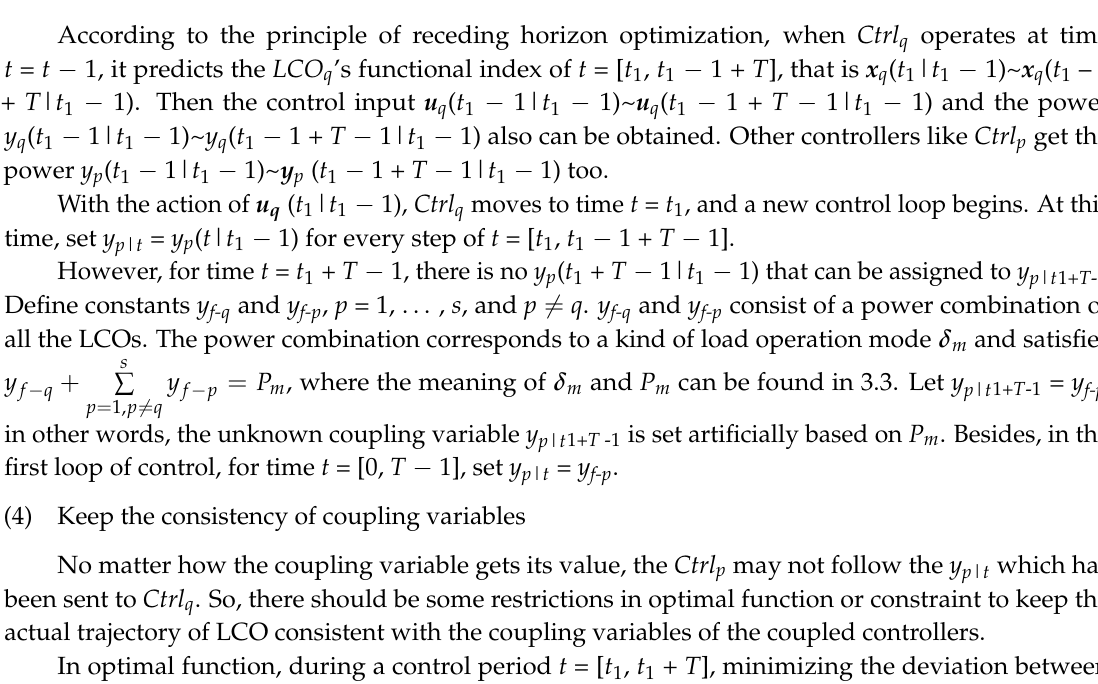
Figure 12. The relationship of coupling information among controllers.